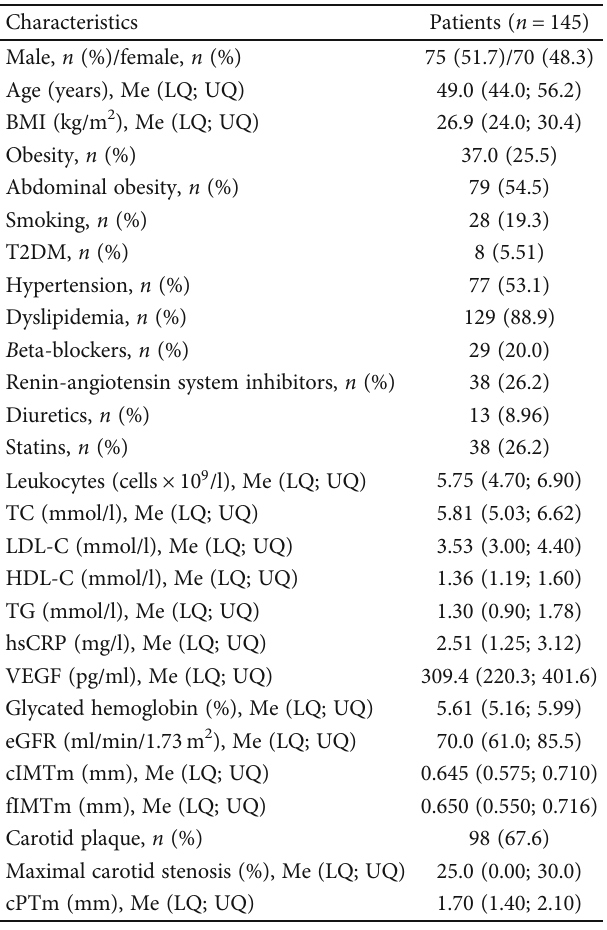
Table 1: Clinical and laboratory characteristics of patients.